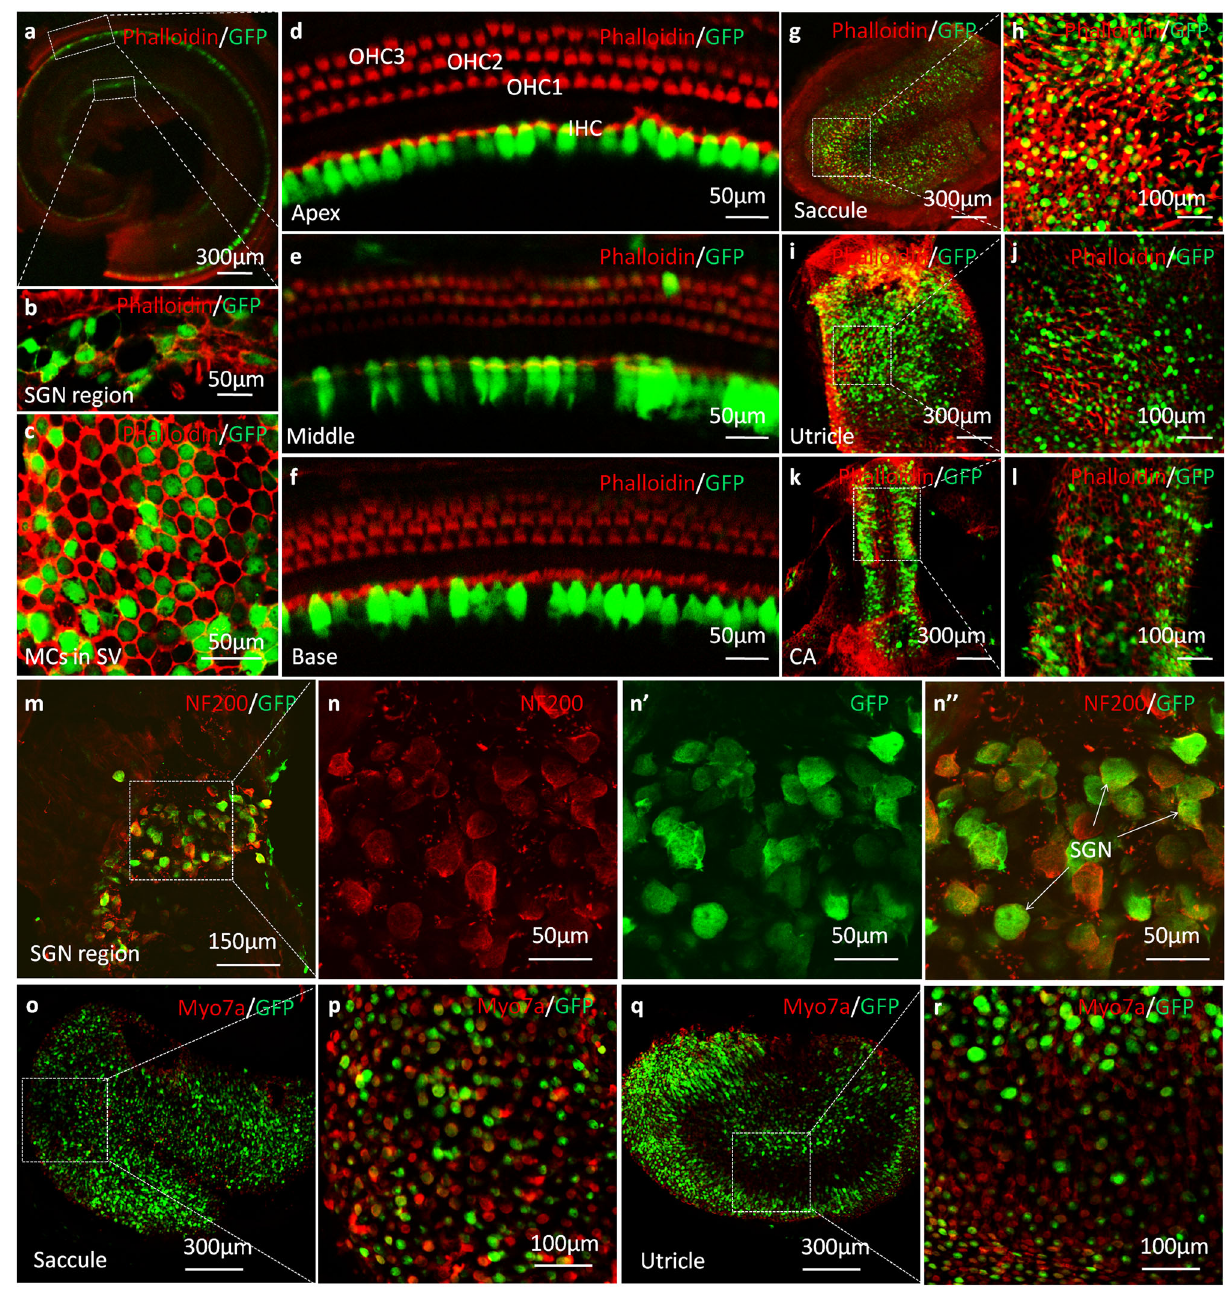
Fig. 1 Confocal immuno fl uorescent images of whole-mount preparations of cochleae and vestibules in WT mice at 1 month after AAV1-CB7- GFP delivery via PSCC injections at P0 – P2 (green: GFP; n = 6 in each group). a A representative low-magni fi cation image of an apical middle turn. b A high- magni fi cation image of the spiral ganglion neuron (SGN) tissue. c A high-magni fi cation image of marginal cells (MCs) in the stria vascularis (SV). d – f High- magni fi cation images of the apex, middle, and base of the basilar membrane. g – j Representative low- and high-magni fi cation images of saccule and utricle. k , l Representative low- and high-magni fi cation images of the crista ampullaris (CA). m Representative low-magni fi cation images of SGNs co-labeled with antibodies against NF200 (red) and GFP . n , n ” Representative high-magni fi cation images of SGNs (boxed area in m ) labeled with antibodies against NF200 ( n , red) and GFP ( n ’ ), n ” is the superimposed images of n and n ’ . o – r Representative low- ( o , q ) and high ( p , r ) magni fi cation images of saccule and utricle co-labeled with antibodies against Myo7a (red) and